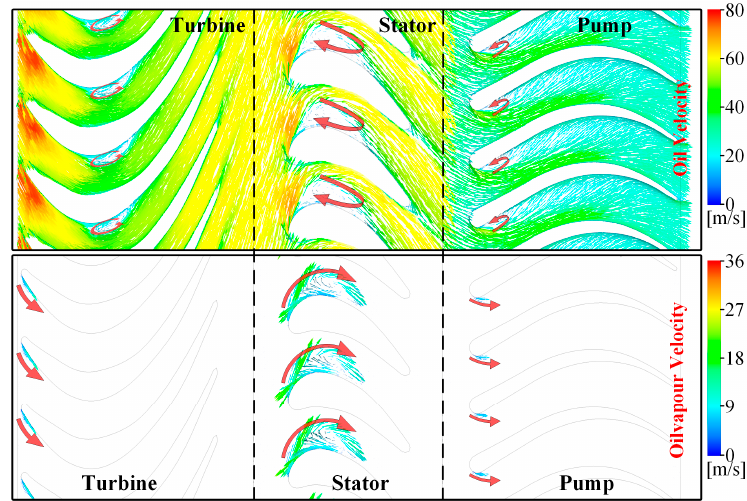
Figure 9. The velocity vector of oil and vapor distribution in torque converter at stall when N P = 3000 rpm.